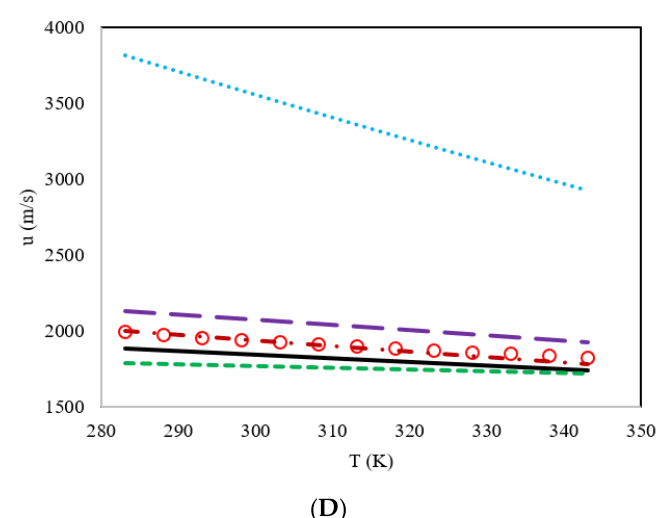
Figure 5. Comparison of the behavior of the speed of sound versus the temperature for the proposed model and literature models for four members of the DES family having benzyl trimethyl ammonium chloride as the HBA and the different HBDs of ethylene glycol(DES8) ( A ), diethylene glycol (DES9) ( B ), triethylene glycol (DES10) ( C ) and glycerol (DES11) ( D ). Experimental data o , proposed model